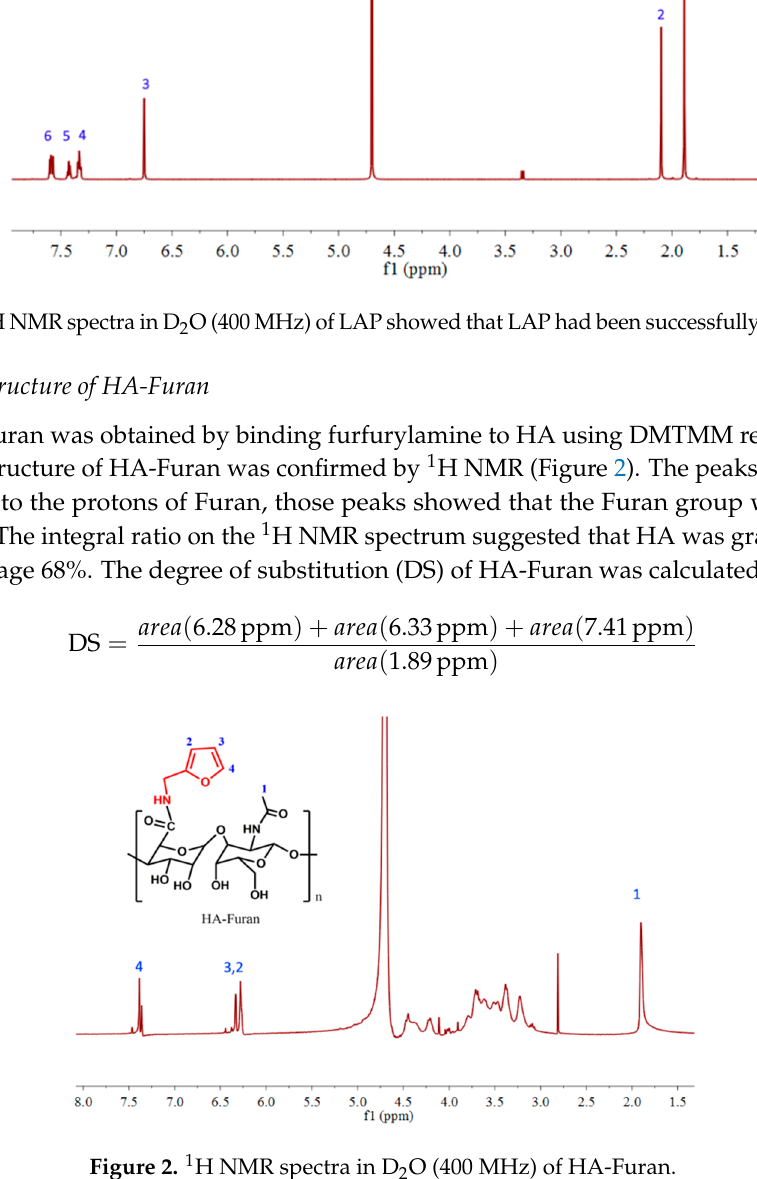
Figure 2. 1 H NMR spectra in D 2 O (400 MHz) of HA-Furan.